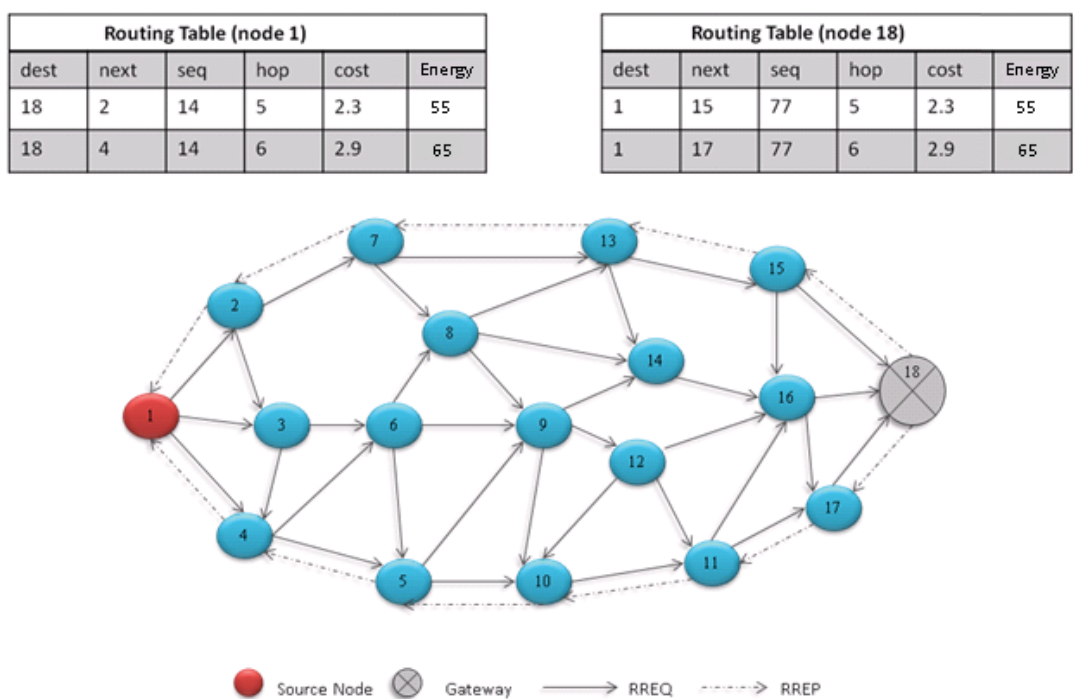
Figure 5. Overview of the multipath discovery